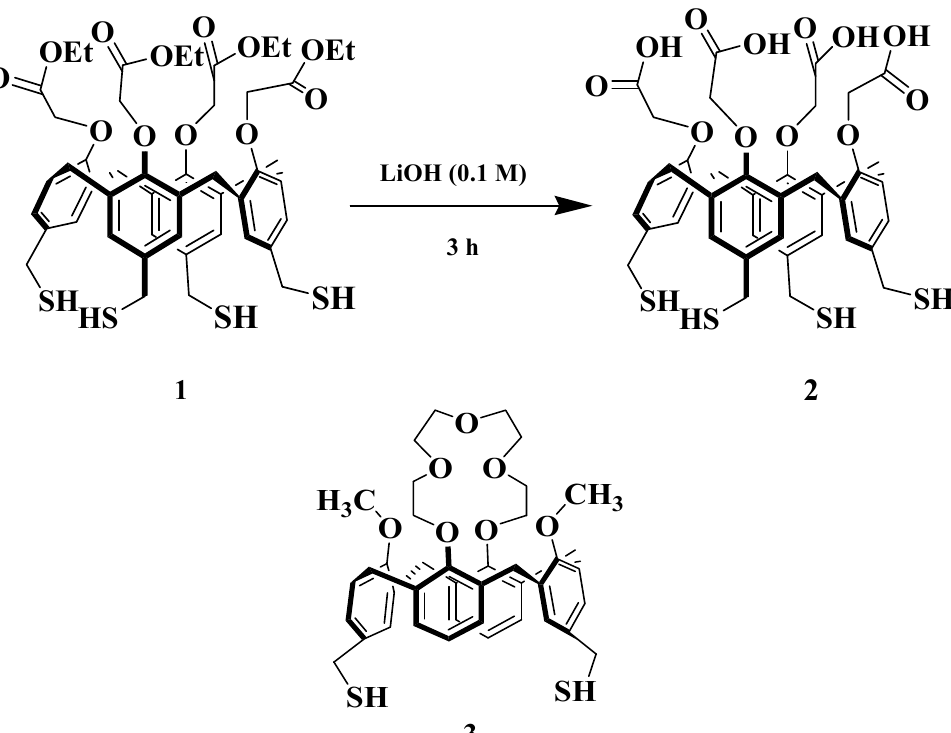
Figure 2. Molecular structure of calix[4]arene derivatives used in this